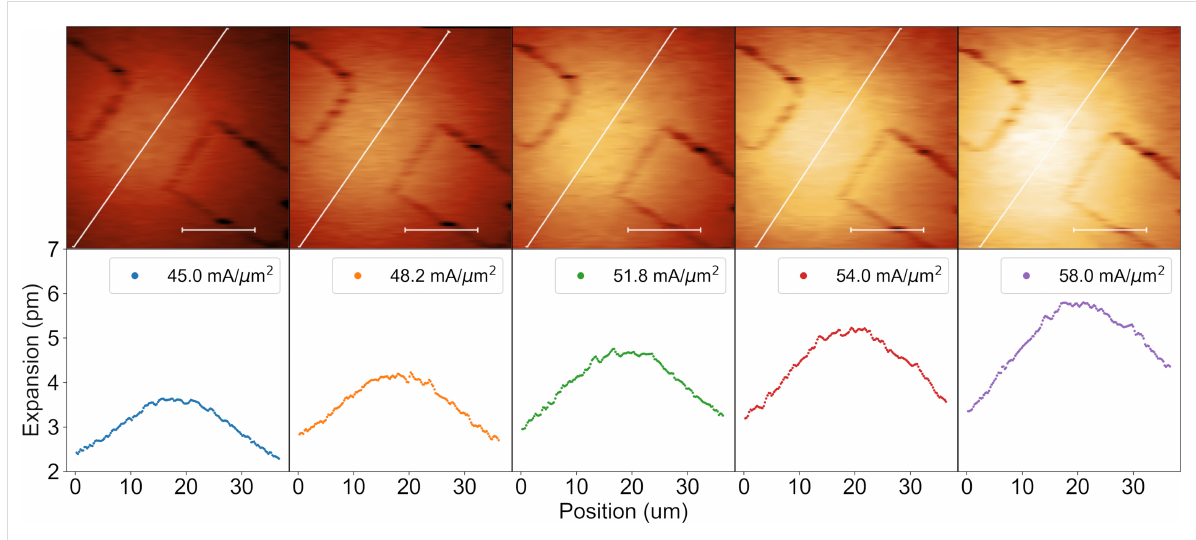
Figure 11: Thermal expansion of active element at varied current densities of 45.0, 48.2, 51.8, 54.0, and 58.0 mA/ μ m 2 . Accompanying line profiles show expansion along the centre, represented by white lines shown in the SJEM images, of the element. The scale bars provided on the SJEM Images are 10 μ m wide. Errors are assumed to be the same as shown in Figure 10 for all measurements shown.